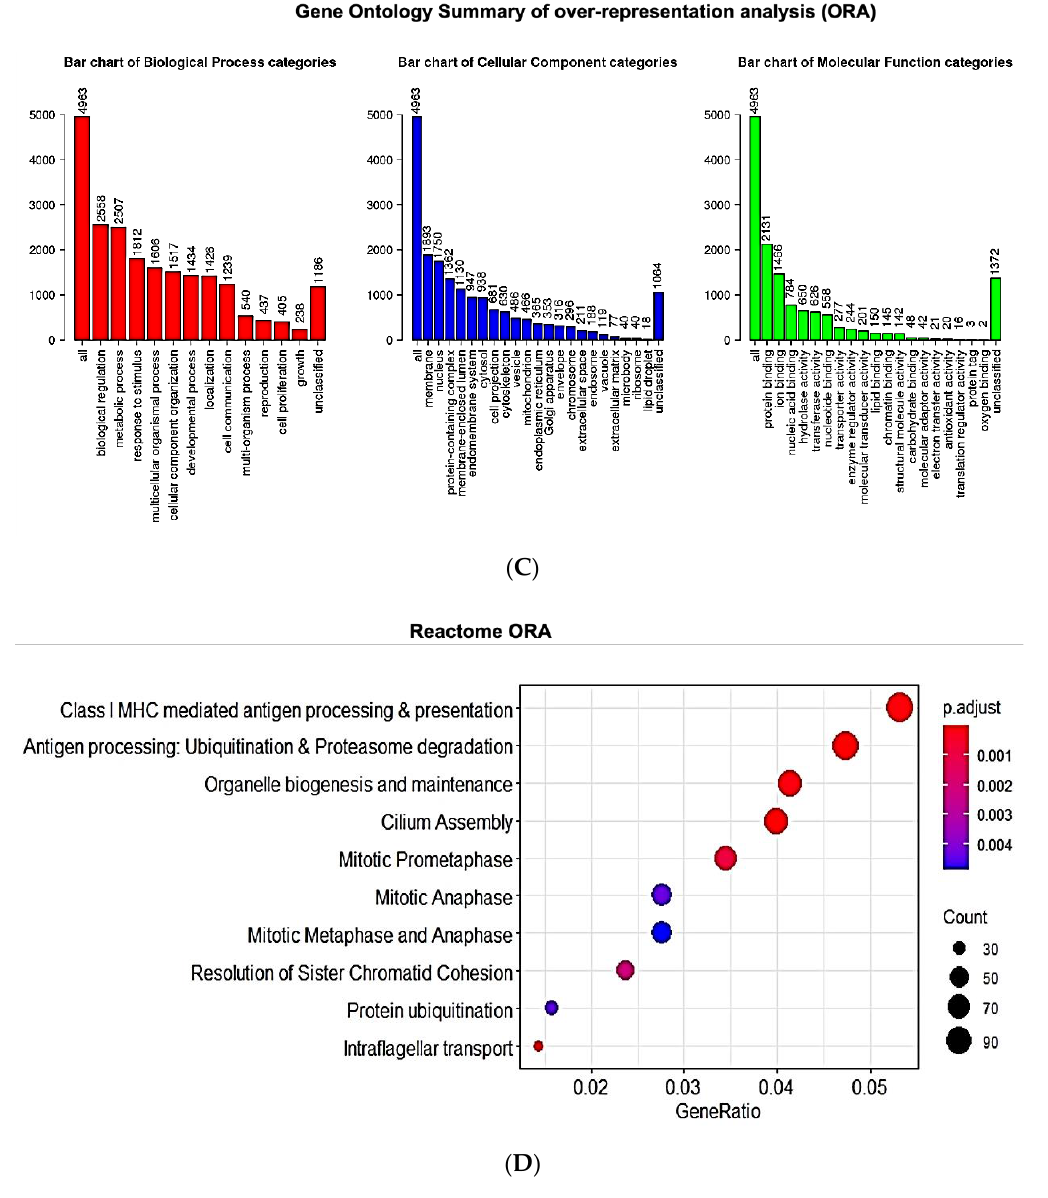
Figure 1. ( A ) Volcano plots of gene expression in PNx vs. Control (left panel) and PNx + NaKtide vs. PNx (right panel) plotting antilog of unadjusted p -value on y-axis vs. log 2 Fold Change on x-axis. Genes downregulated (unadjusted p -value of <0.1) by PNx colored orange and genes upregulated (unadjusted p -value of <0.1) by PNx colored blue. We note that addition of NaKtide expression moved upregulated genes down and downregulated genes up. ( B ) Heat map of gene expression in top 100 up and 100 downregulated genes with PNx. Color coding based on log 2 Fold Change with legend shown below. We note little difference between NaKtide and Control, but the addition of NaKtide to PNx appears to normalize both up and downregulated gene expression. ( C ) Gene Ontology summary of over representation analysis (ORA) in PNx mice model. Gene ontology annotation of biological processes, cellular components and molecular function categories. ( D ) Reactome ORA of differentially expressed genes in PNx mice model. The scatter dot plot of reactome enrichment representing the number of differentially expressed genes enriched in GO terms. p -value and gene ratio (number of differentially expressed genes in GO term)/(total number of genes in GO term) are shown in the plot. Larger circles indicate more enriched genes.